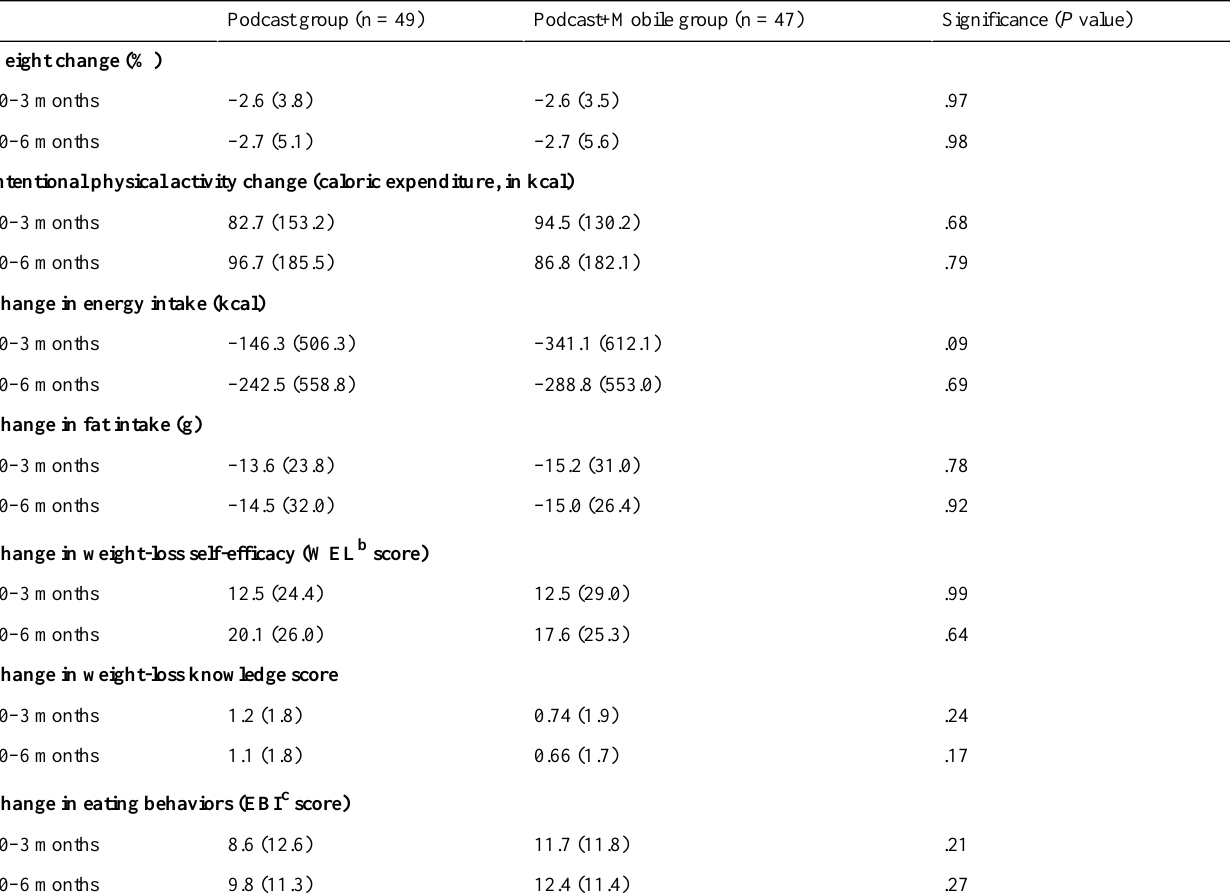
Table 2. Changes in weight, physical activity, dietary intake, self-efficacy, knowledge, and eating behaviors at 3 and 6 months a